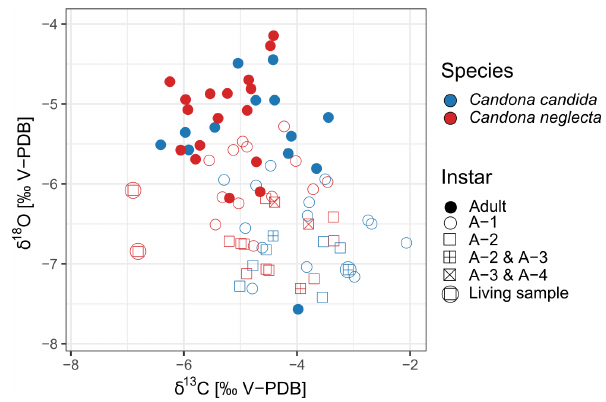
Figure 8. Isotopic composition ( δ 18 O and δ 13 C) of the valves from two species of ostracods, Candona candida (blue) and Candona ne- glecta (red), taken from living specimens (encircled symbols) and subfossil samples in the surface sediments of Lake Locknesjön. The symbols represent the instars. See Sect. 2.3 for explanation of the combinations of different